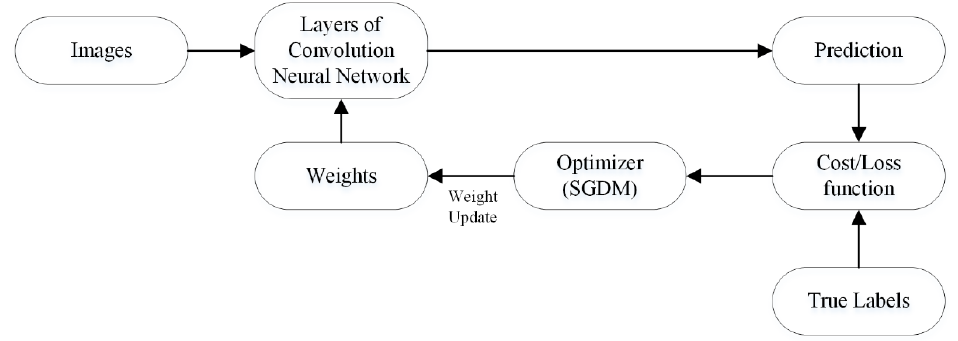
Figure 3. The weights update/learning process of convolutional neural network.